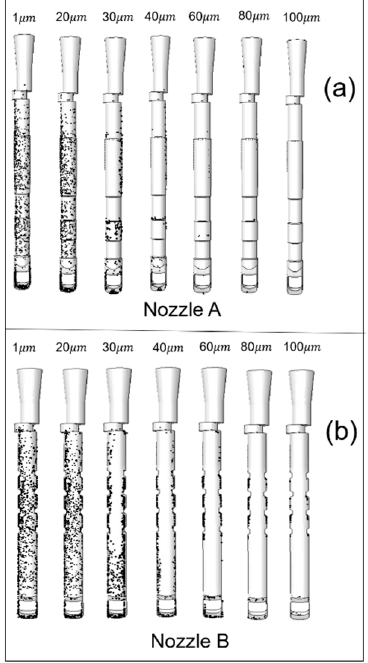
Figure 10. Schematic deposition of the inclusion distribution along the nozzle length for ( a ) Nozzle A and ( b ) Nozzle B considering several inclusion sizes.